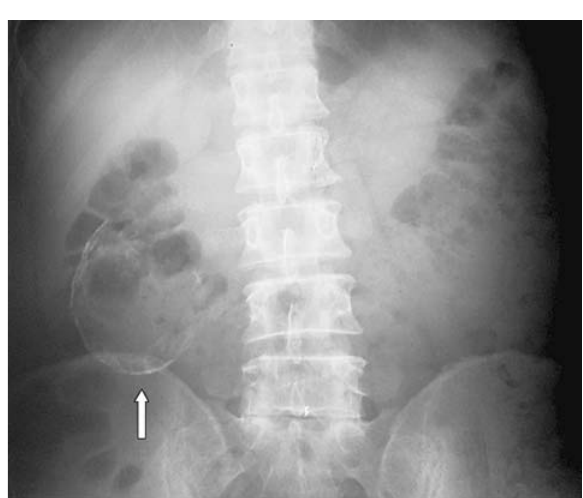
Figure 1 – Kidneys, ureters and bladder X-ray showing eggshell calcification in the region of right